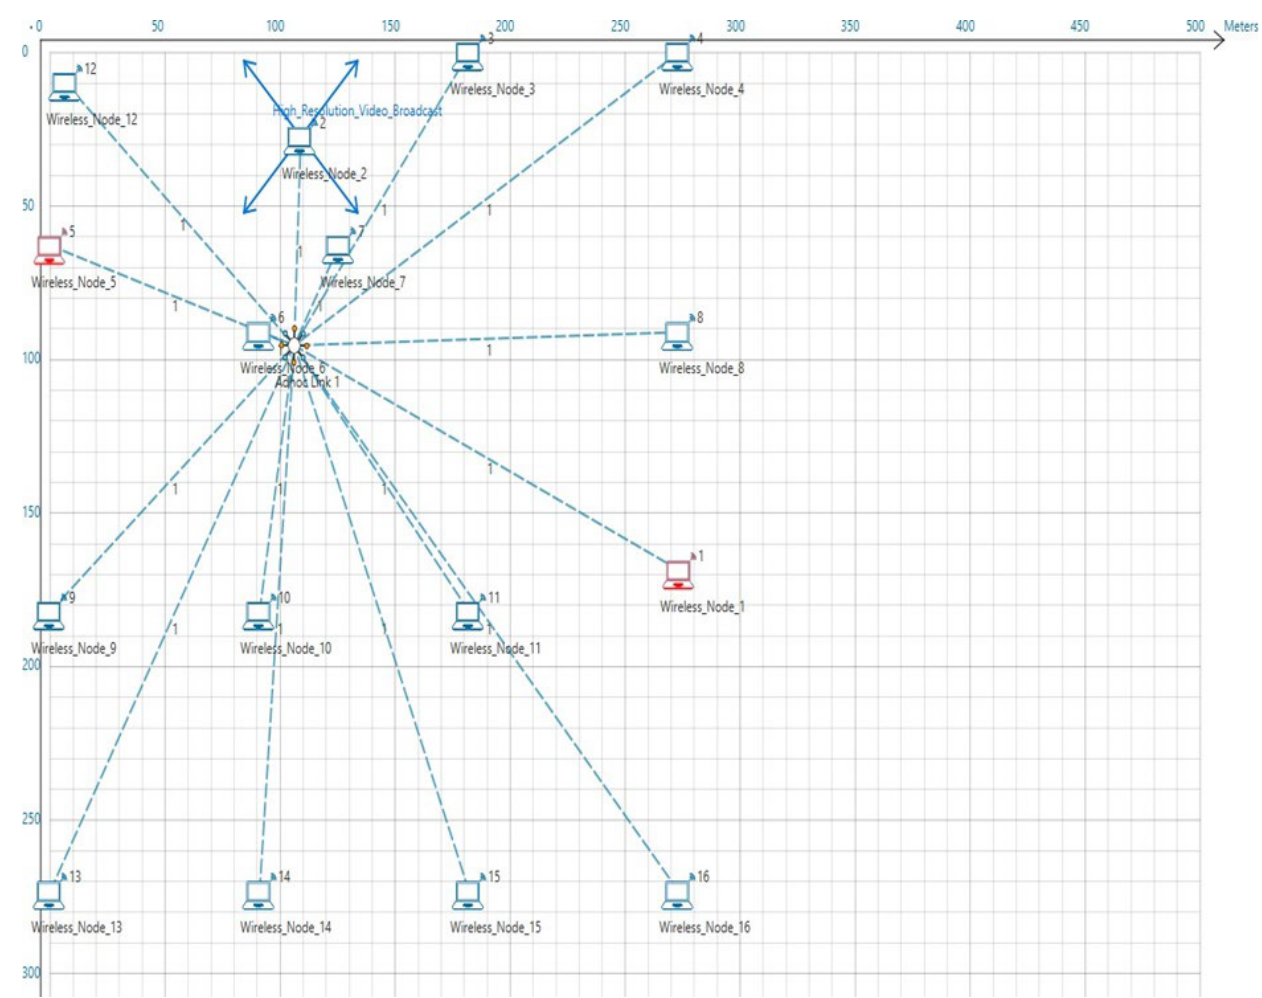
Figure 9. Network model of 16 nodes with two sinkhole nodes added.